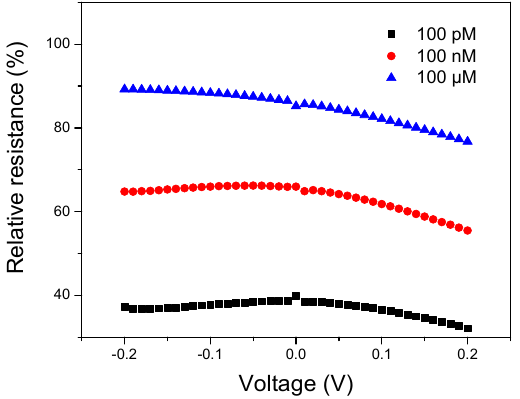
Figure 8. Effect of the V DS ranging from −0.2 V to 0.2 V on the performance of the biosensor with the three Ag(I) concentrations (100 pM, 100 nM, 100 μM) at V G = 0 V.